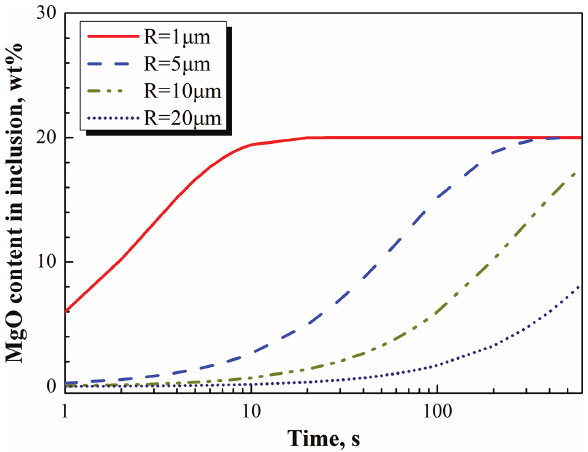
Figure 10: MgO content in inclusions as a function of time by using calculation